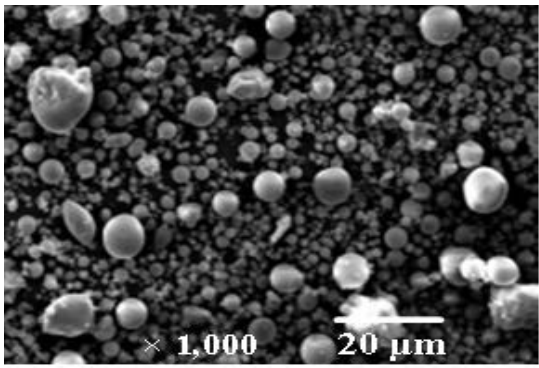
Figure 1. Scanning electron micrograph of fly ash (FA). Table 2. Chemical composition of the FA (wt.%).